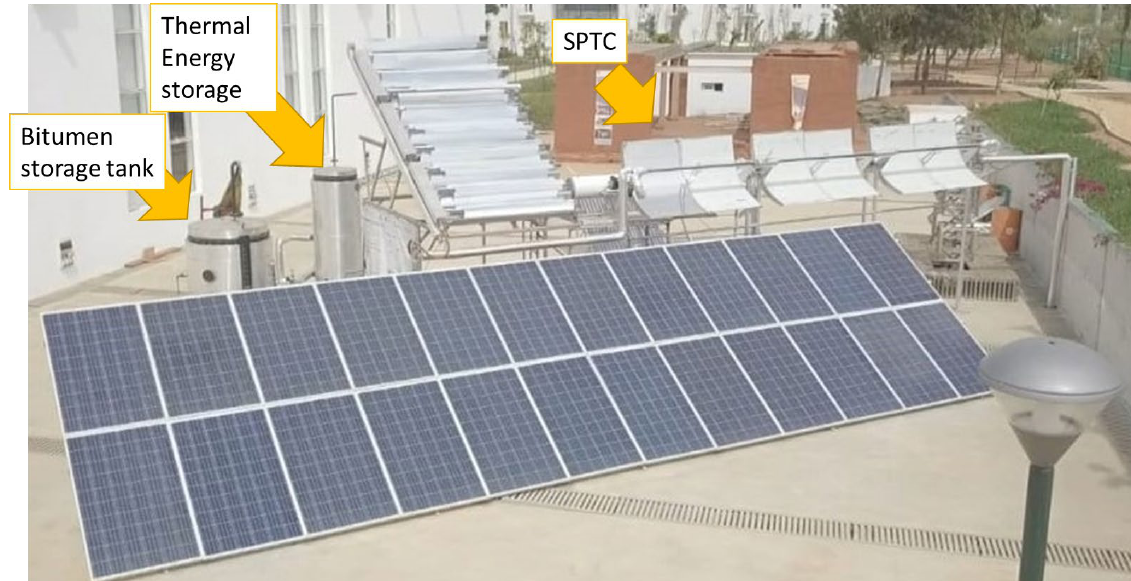
Figure 1. Experimental setup of the industrial process plant at the UIR campus.